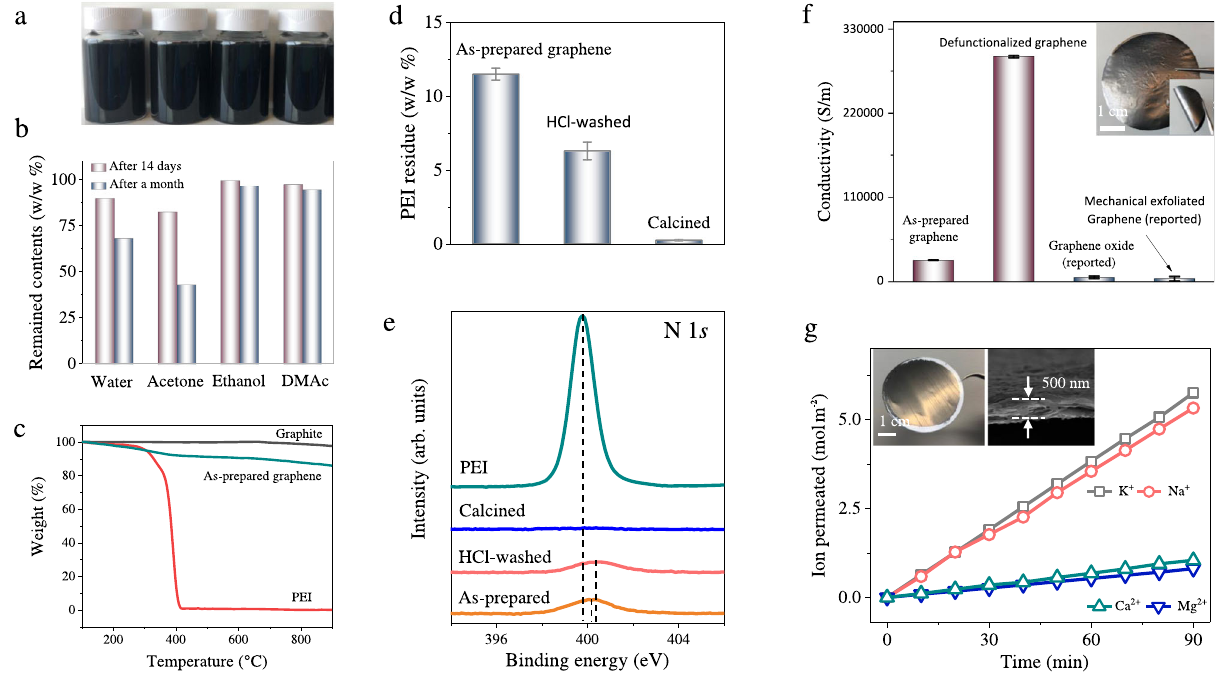
Fig. 2 | Properties and potential applications of the exfoliated graphene nanosheets. a Photograph of graphene nanosheets (10h milling) dispersed in solvents including water, ethanol, isopropanol (IPA) and dimethylacetamide (DMAc)ataconcentration of 0.5mg/mL. b The weight ratio ofremained graphene nanosheets in these solutions after fortnight and 30 days, respectively. c Thermogravimetric analysis (TGA) of graphite, polyethyleneimine (PEI) and exfoliated graphene (10h milling), respectively. d Content of residual PEI on as- prepared graphene (10h milling) and de-functionalized graphene by acid washing and incineration under N 2 atmosphere. e High-resolution X-ray photoelectron spectroscopy (XPS) spectra of N 1 s of PEI, as-prepared graphene and de- functionalized graphene. The dashed lines highlight the peak shifts. In pure PEI, a sharp peak at 399.8eV was recognized as typical groups of -N/NH/NH 2 in PEI.